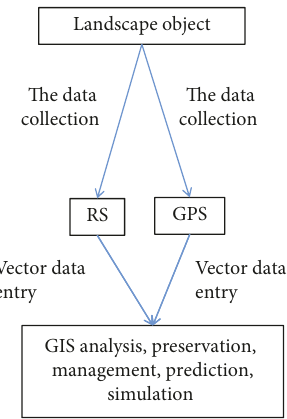
Figure 2: Flowchart of collection and processing of landscape information by 3S